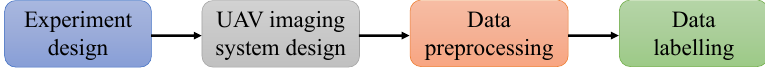
Figure 1. Flowchart of field experiment design in this